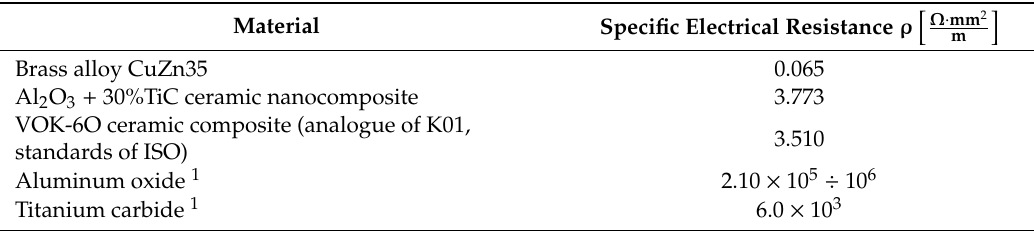
Table 1. Specific electrical resistance ρ of some materials at +20 °C.